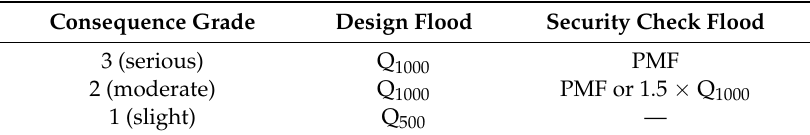
Table 13. Design flood and security check flood in terms of dam